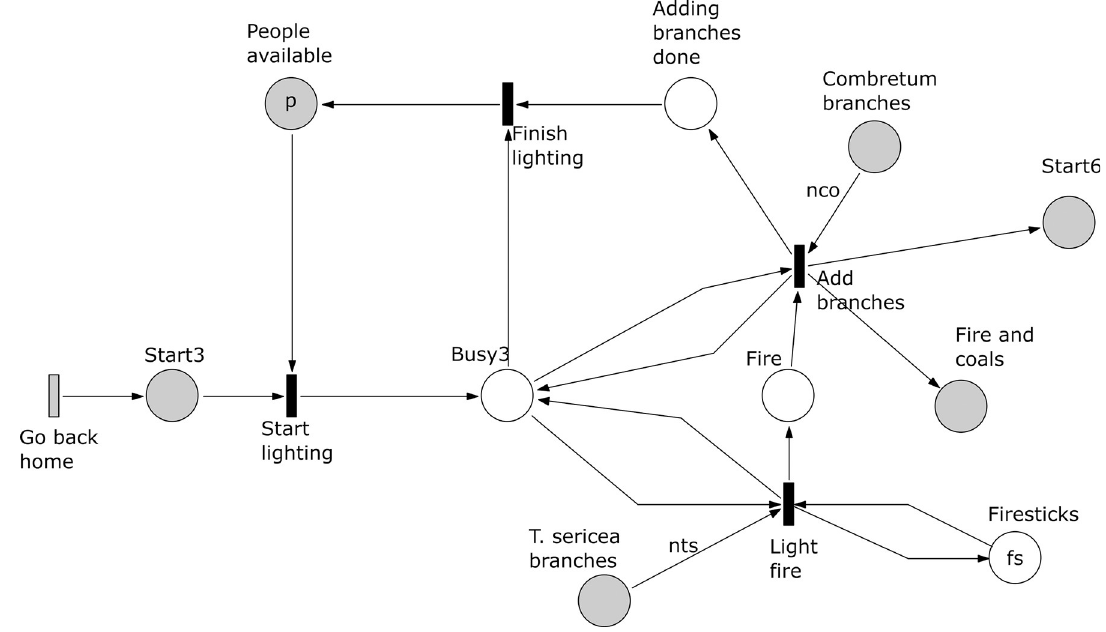
Fig 14. Subprocess 3 Light Fire of the O . Schinzii